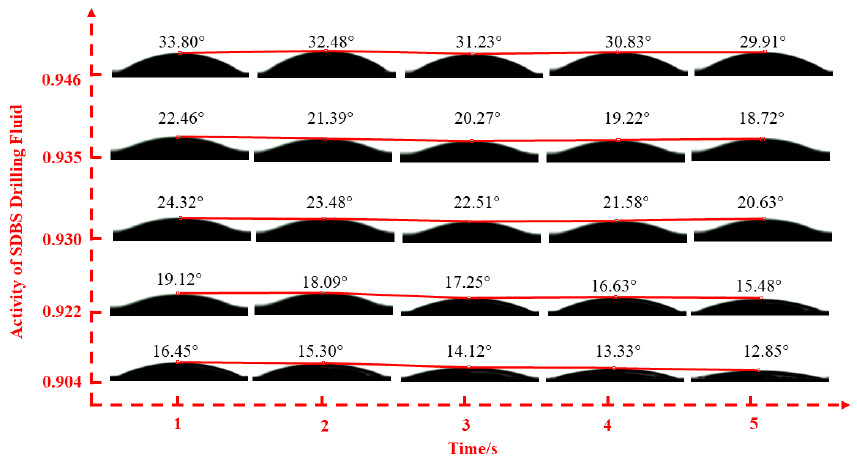
Figure 3. The evolution of fluid–shale contact angles for di ff erent activities of sodium dodecylbenzene Figure 2. The evolution of fluid–shale contact angles for different activities of sodium sulfonate (SDBS) drilling dodecylbenzene sulfonate (SDBS) drilling fluid.